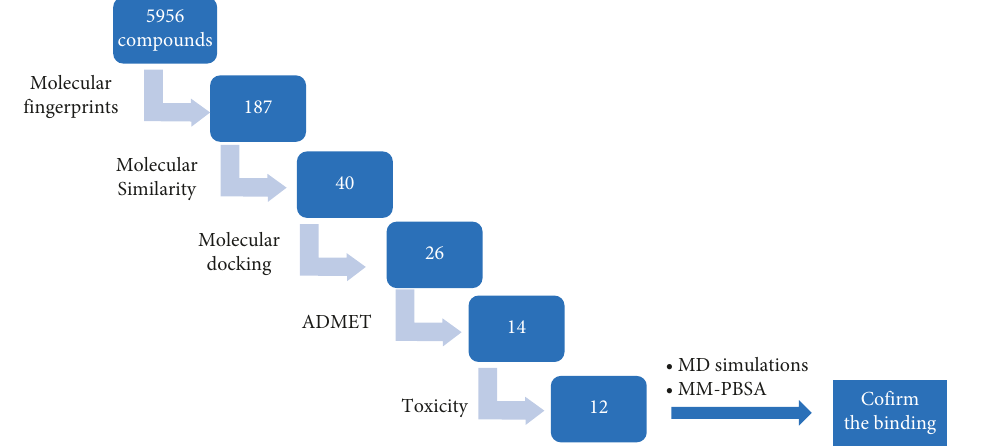
Figure 1: The employed computational techniques. Table 1: Fingerprint similarity between 187 natural compounds and VXG